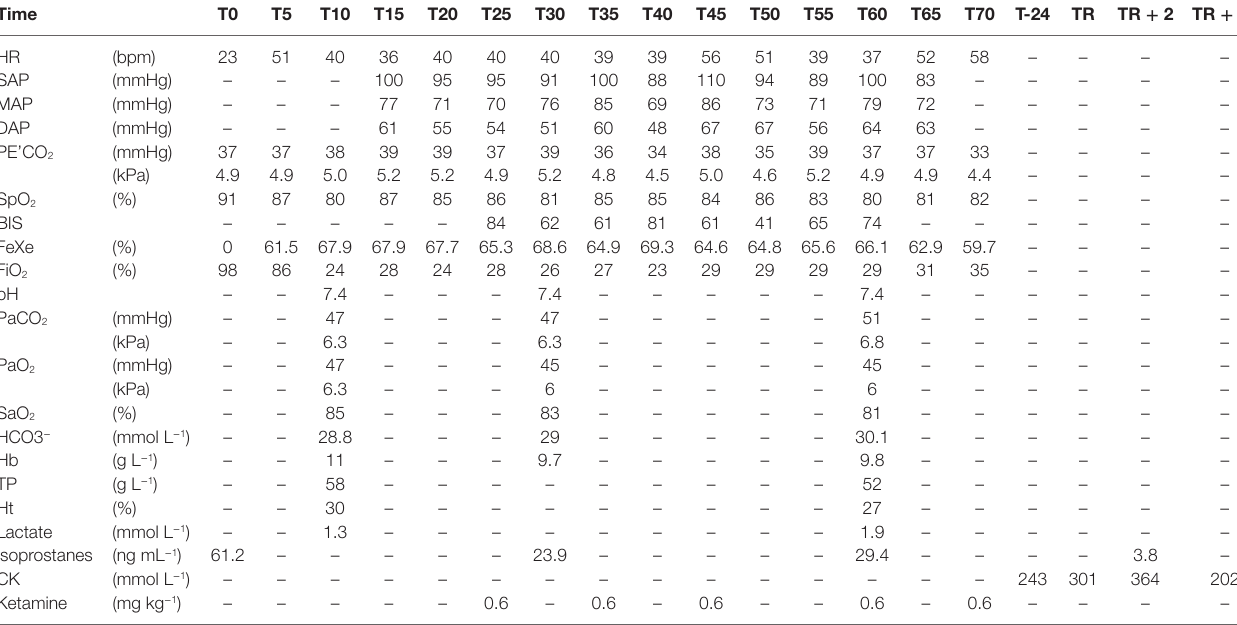
Table 3 | Physiological data measured over a 70 min period in a horse during general anesthesia with xenon (70%) and oxygen (30%), co-administered with a lidocaine CRI at 0.05 mg kg − 1 min − 1 . Time